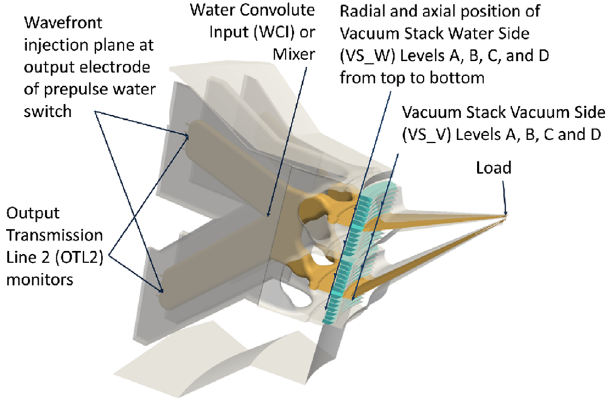
FIG. 9. Simulation geometry for the standard four-level MITL-PHC vacuum section configuration (30° symmetric section in